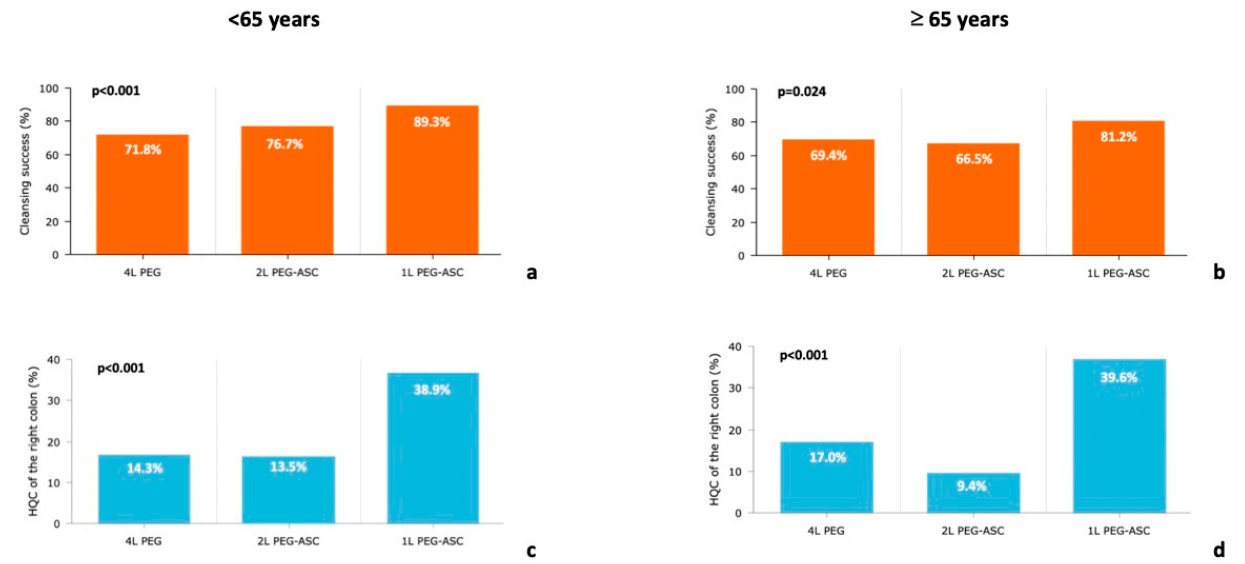
Figure 1. Cleansing success rate by type of bowel preparation in patients <65 years ( a ) and ≥ 65 years ( b ), and high-quality cleansing of the right colon in patients <65 years ( c ) and ≥ 65 years ( d ).